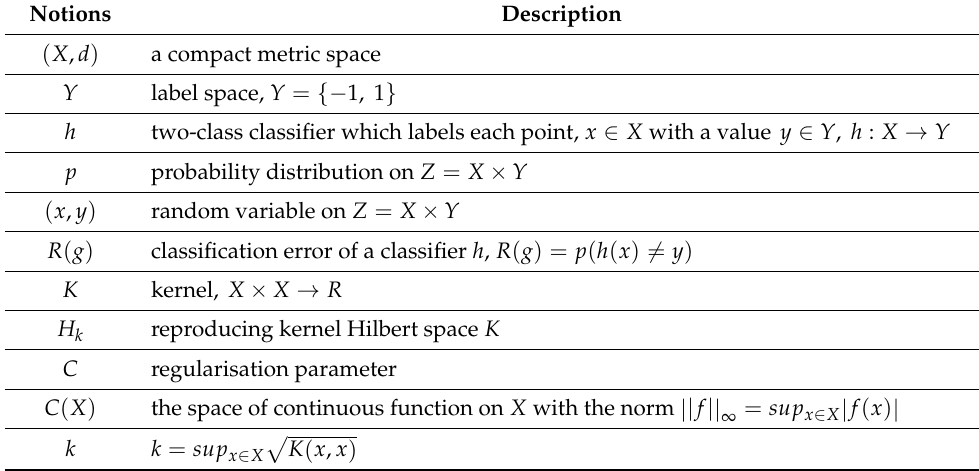
Table 1. Notions of